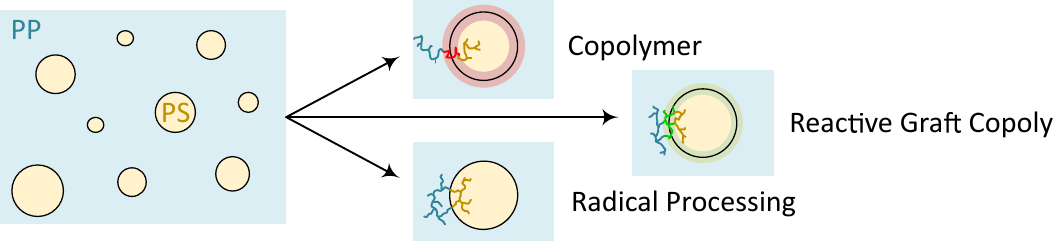
Figure 1. Schematic representation of possible compatibilization mechanisms of the different systems regarding the interface of matrix and dispersed phase.